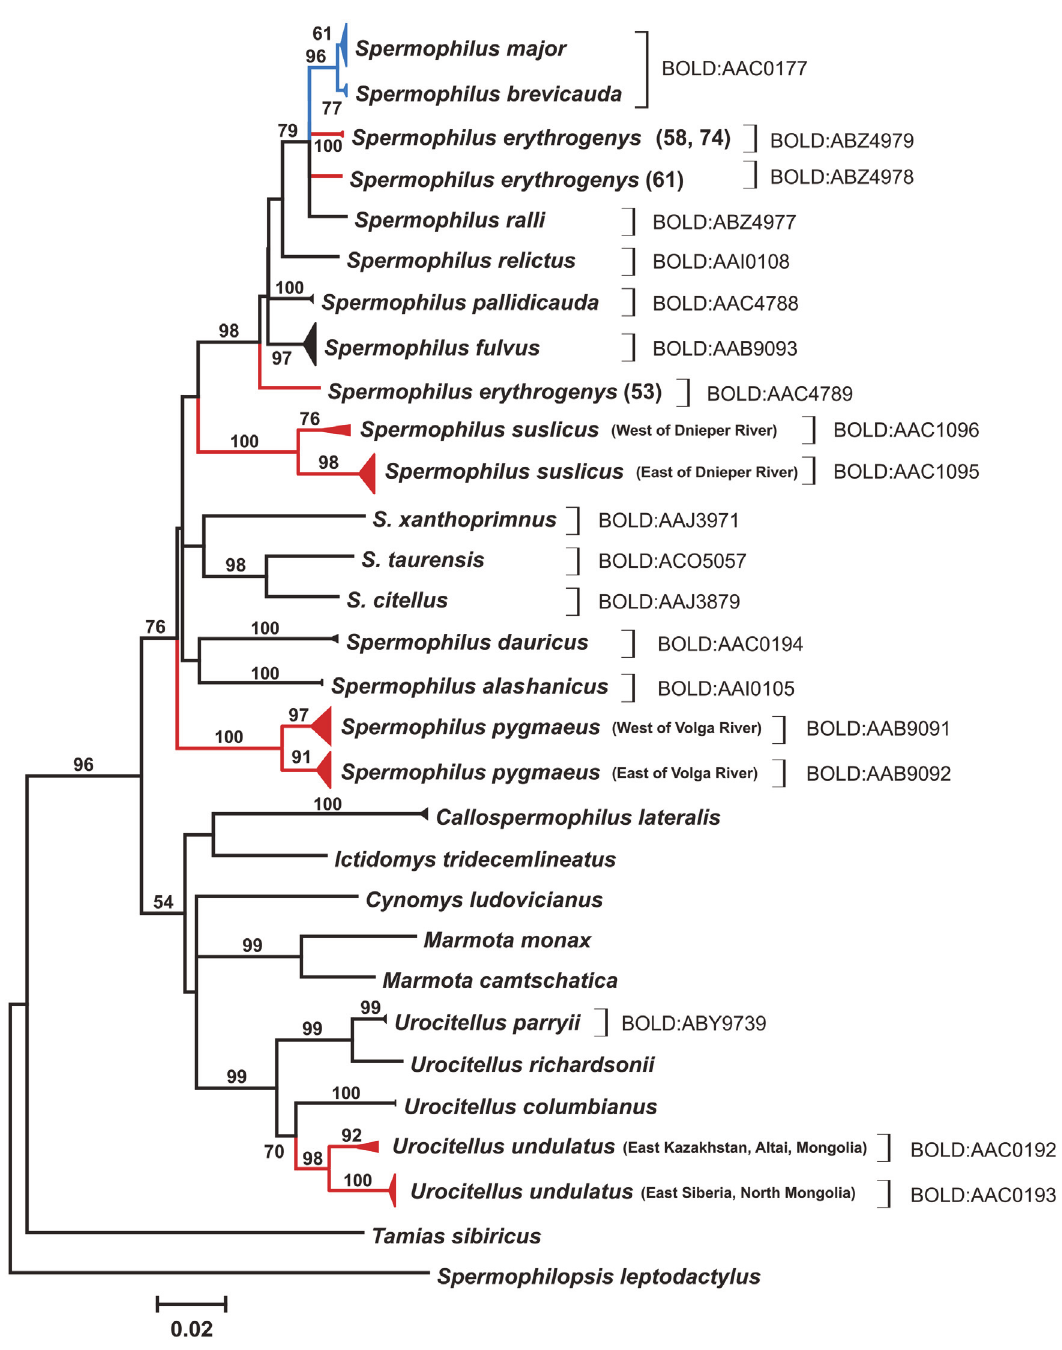
Figure 6. Species delineation of Eurasian ground squirrels by refined single linkage (RESL) analysis showed on the gene tree. Square brackets indicate putative species recognized by RESL. Barcode Index Numbers (BIN) assigned to each putative species are given as BOLD:XXXXXXX. Species split by RESL are red colored, while merged species are blue colored. ML tree (HKY+I+G model) of 657 bp COI fragment. Bootstrap values above 50 are indicated. The nodes with multiple specimens were collapsed to a triangle, with the horizontal depth indicating the level of intraspecific divergence. Individuals with introgressed mtDNA are not included into the